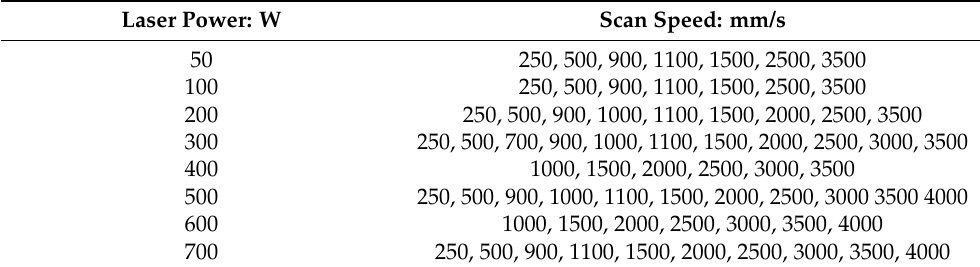
Table 1. The laser power and the scan speed (the translation velocity of the moving laser) in the single-track experiments.